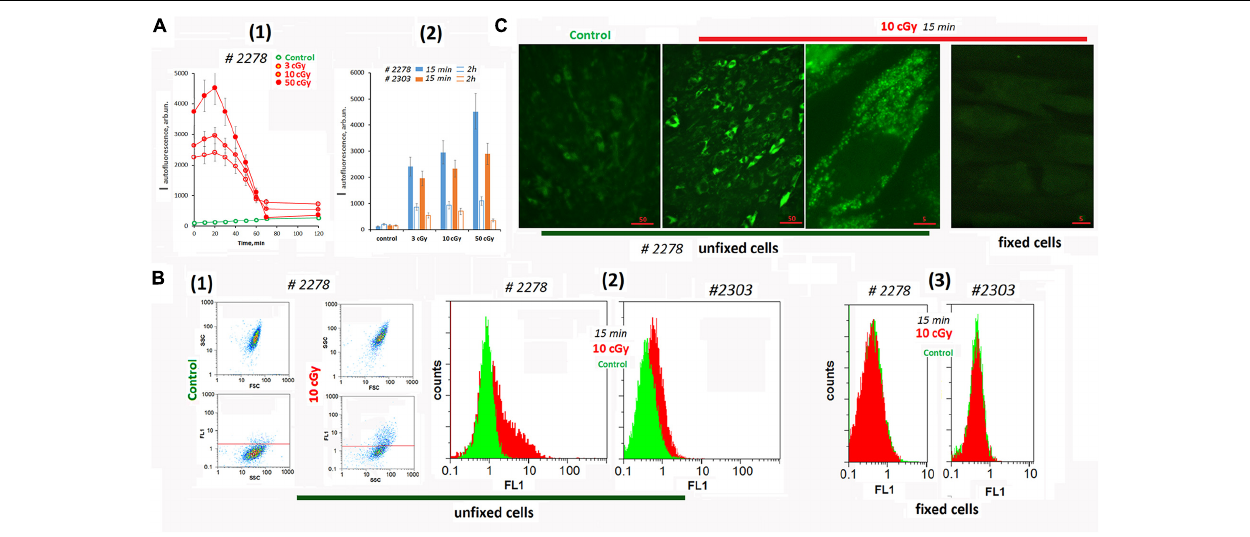
FIGURE 1 | Autofluorescence of the irradiated cells. (A) Plate assay ( λ ex = 490 nm and λ em = 524 nm). (1) Time dependence of the signal after irradiation with doses of 3, 10, and 50 cGy. (2) Comparison of two cell lines by signal intensity 15 min and 2 h after irradiation. Average values are given for two experiments. In each experiment; cells were analyzed in four wells of the plate. (B) FACS. (1) Plots: SSC versus FSC and FL1 versus SSC. (2) The distribution of the unfixed MSCs with varying autofluorescence. (3) The distribution of the fixed MSC (10 cGy) with varying autofluorescence. The experiment was repeated three times. (C) Fluorescence microscopy of irradiated unfixed and fixed with 3% paraformaldehyde MSCs. The experiment was repeated three